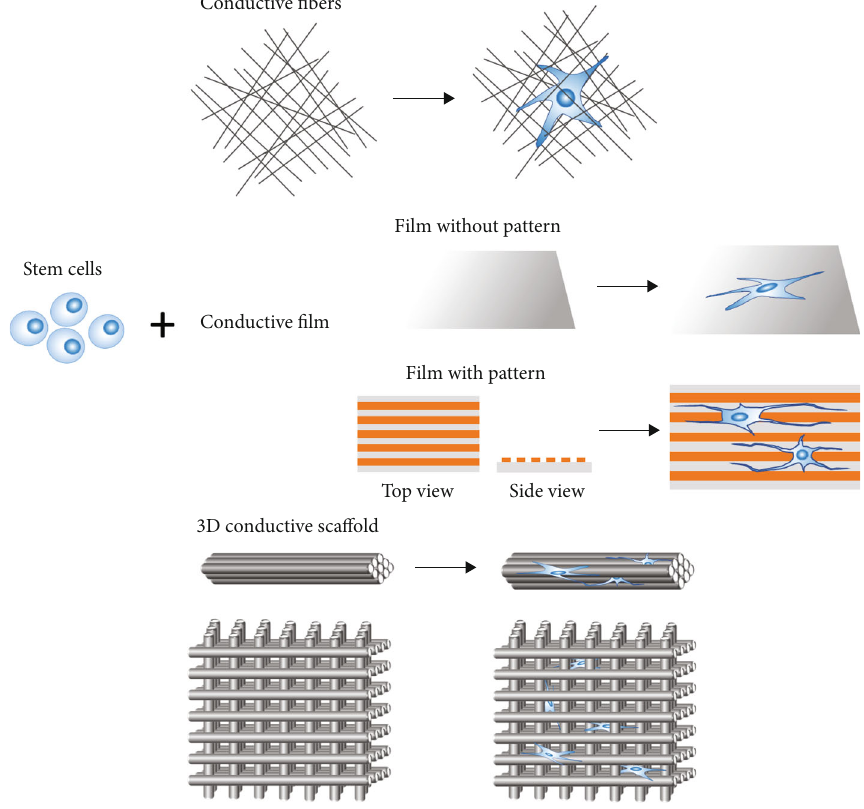
Figure 2: Schematic diagram of structures of conductive materials used for neural tissue